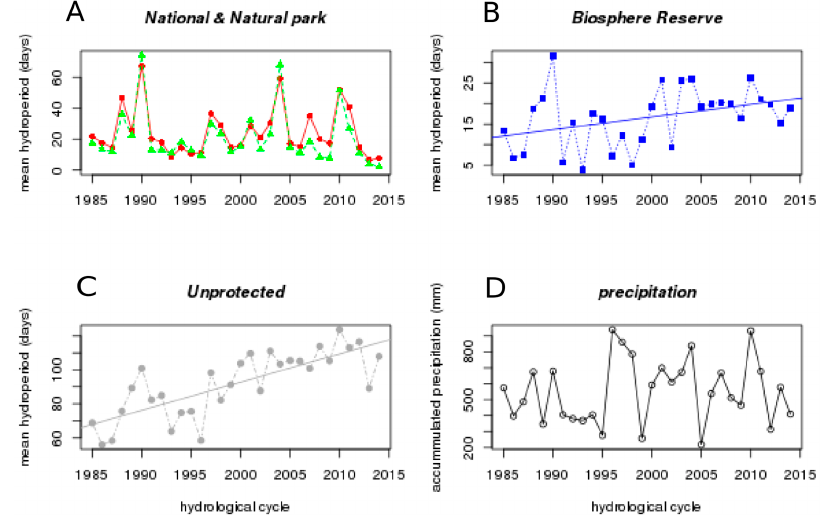
Figure 3. Temporal trends of mean pixel hydroperiod of temporary waters in each protection level and annual precipitation on the “Almonte-Marismas” aquifer. ( A ) Red circles = National Park, green triangles = Natural Park; ( B ) blue squares = Biosphere Reserve; ( C ) gray circles = unprotected; ( D ) precipitation trend. Only statistically significant trend lines are shown.